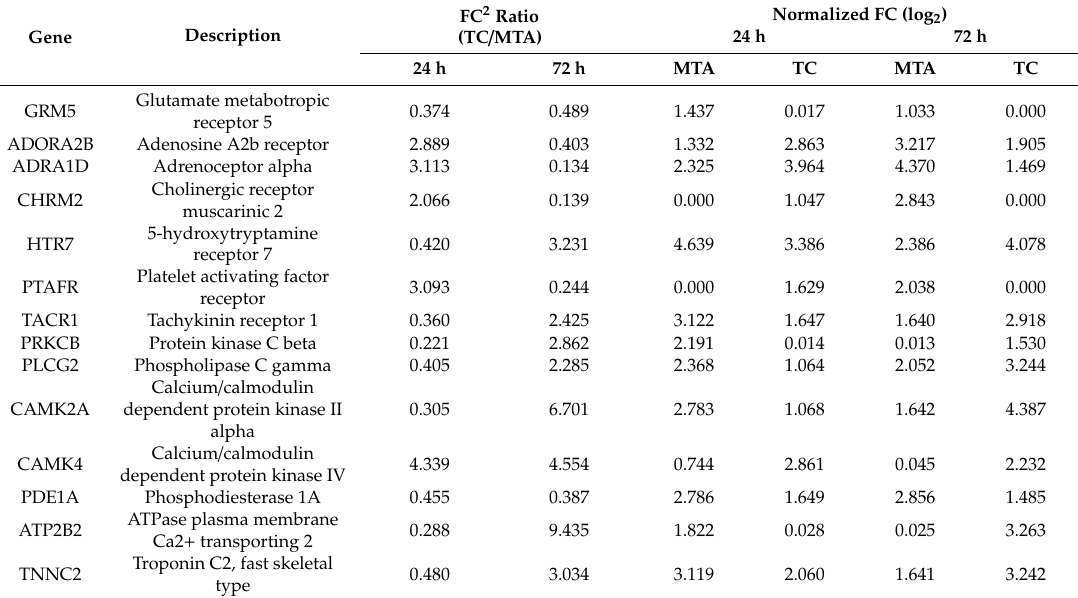
Table A2. DEGs involved in calcium signaling pathway in TC for 24 h and 72